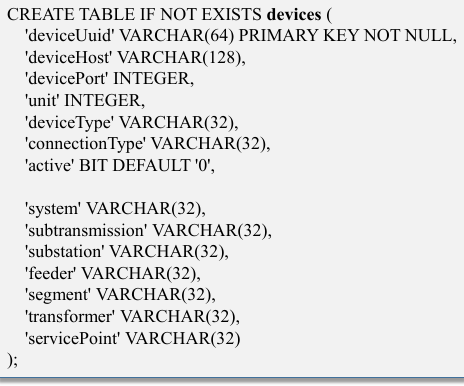
Figure 21. IEEE 2030.5 database